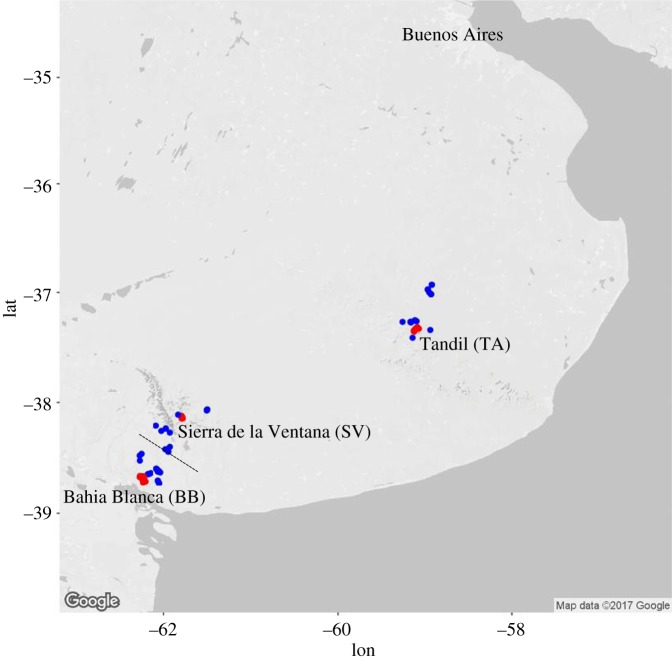
Sampling locations of urban sites (red) and rural sites (blue). The dotted line indicates the division between the two rural sampling sites BBrural and SVrural halfway between the cities.